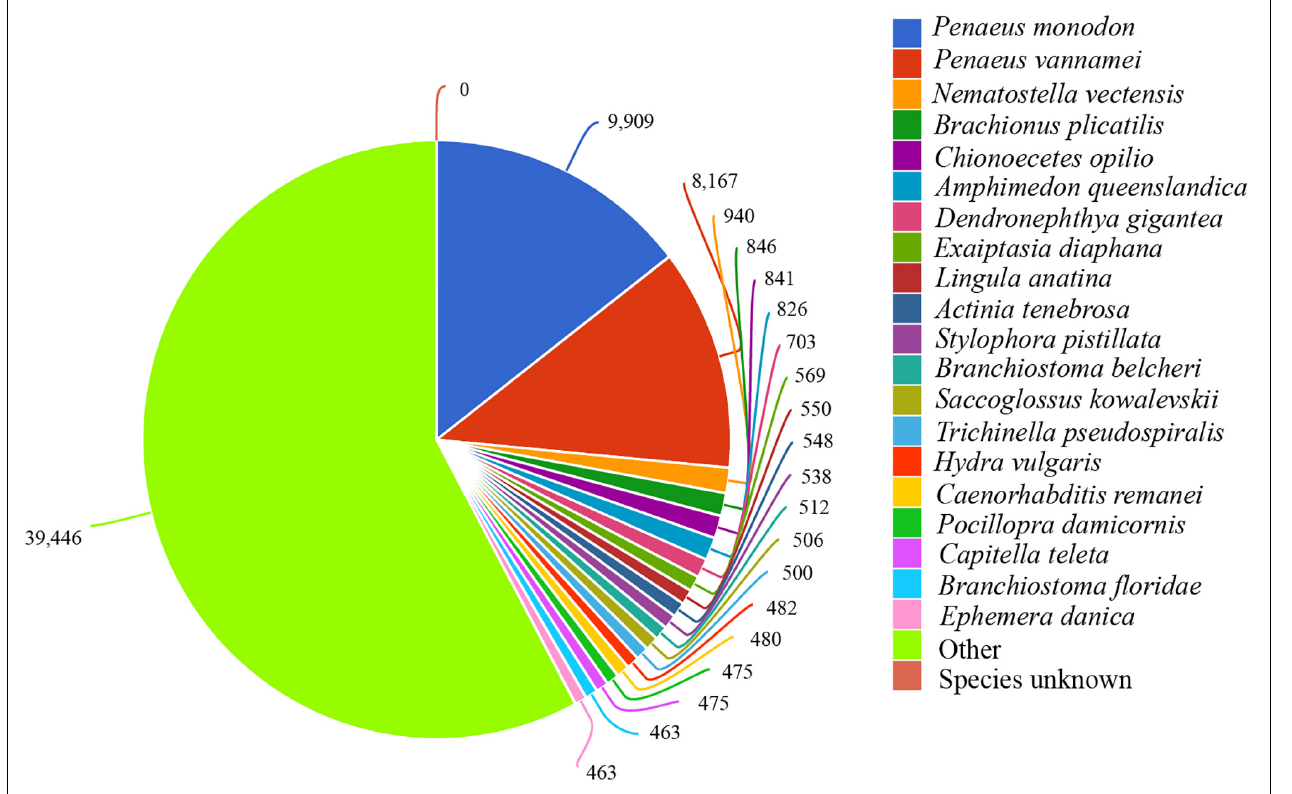
FIGURE 1 | Species distribution of the sequence. Each sector in the figure represents a related species. The larger the area of the sector, the more sequences of the species are aligned. The number represents the amount of aligned sequences.